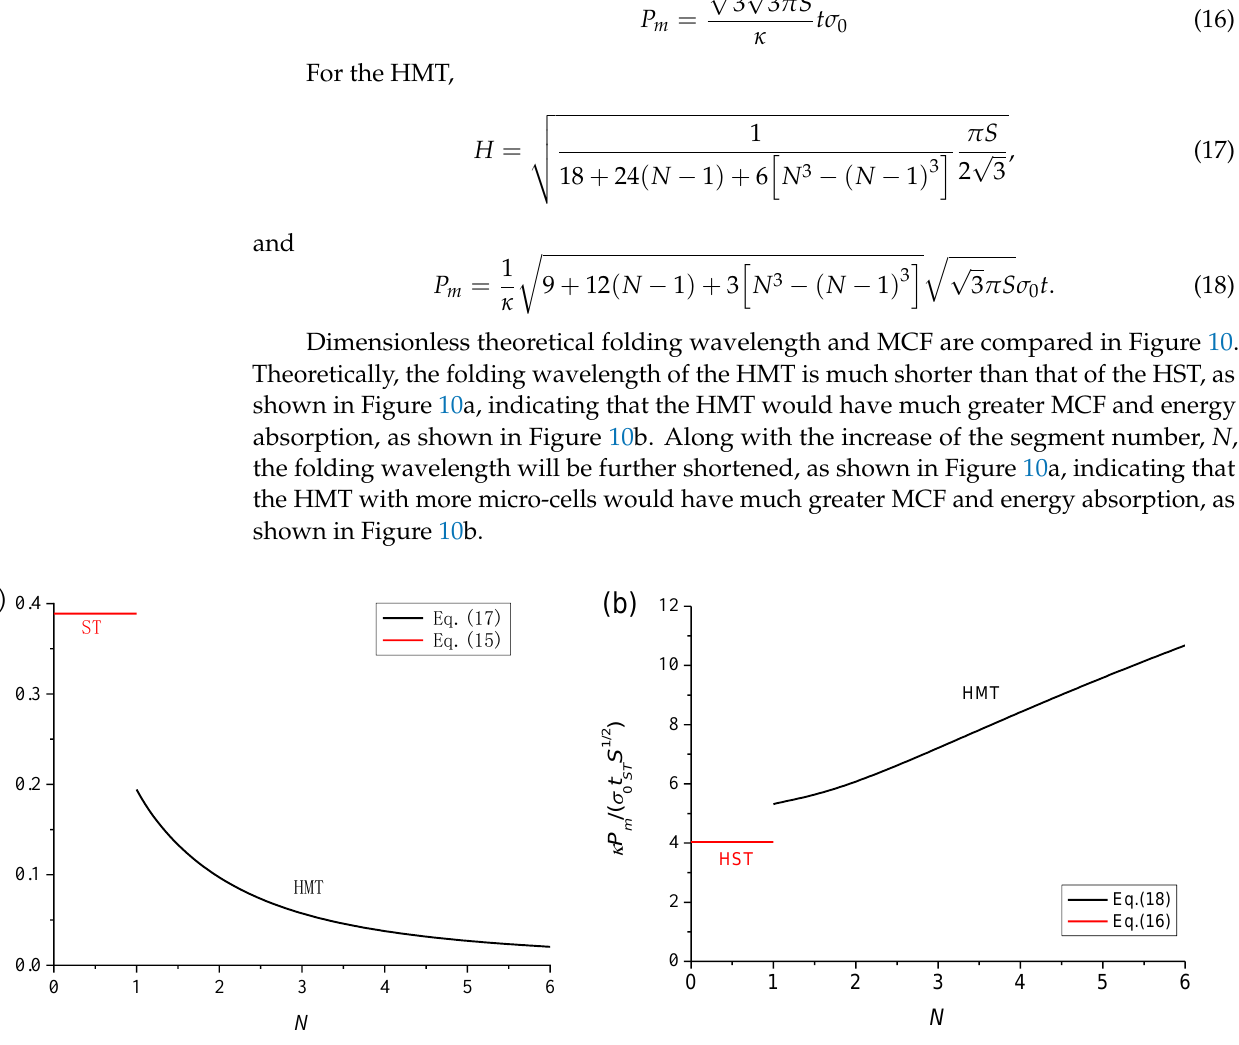
Figure 10. Dimensionless theoretical ( a ) folding wavelength and ( b ) MCF. Table 5. Comparisons between theory and test of MCF based on PF method.